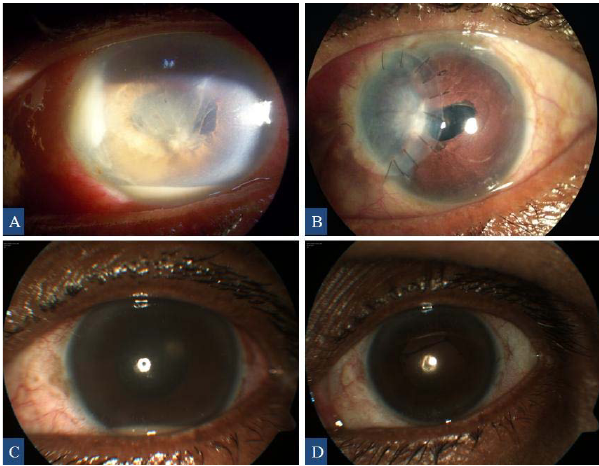
Figure 1. Anterior segment images showing nasal corneal abscess, hypopyon, and fibrinous exudates at the time of presentation (A) and corneal patch graft at the last visit (B) of case 12. Anterior segment images of case 13 showing recurrence of hypopyon (C) and postoperative image at the last visit with no hypopyon